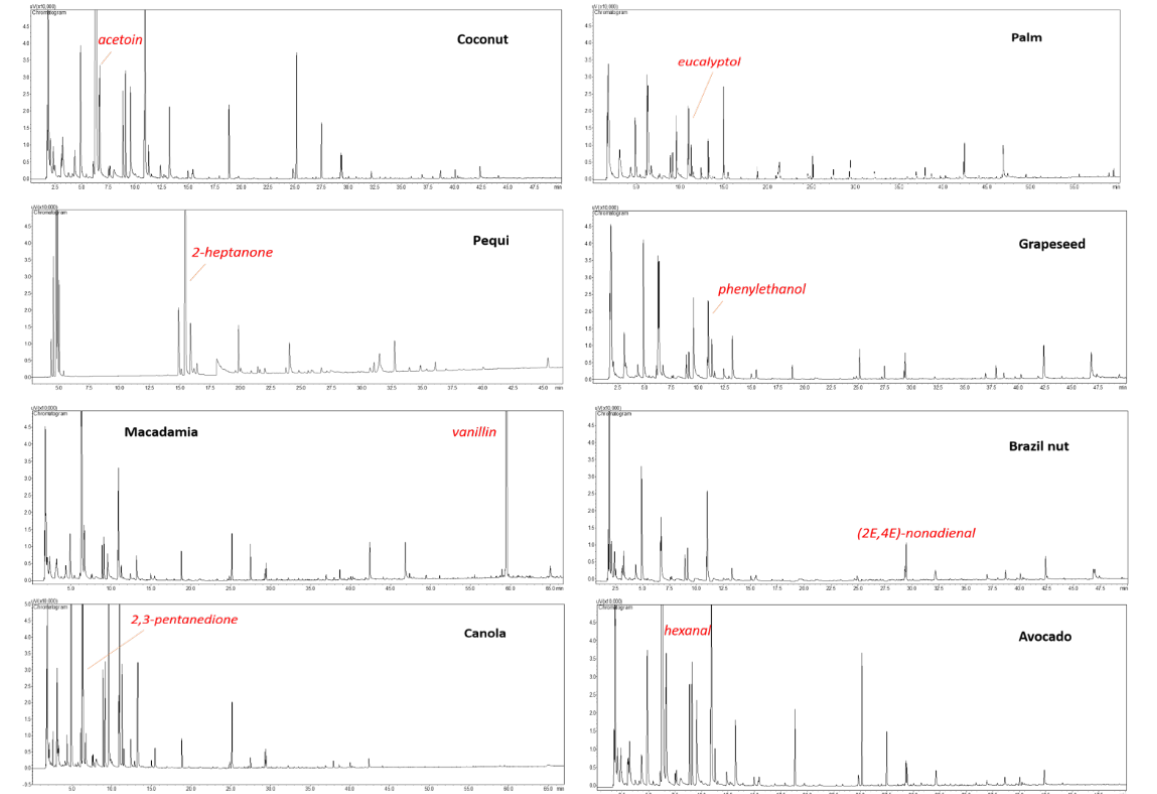
Figure 1. HS-SPME-GC-FID chromatograms of the eight Brazilian cold-pressed oils.